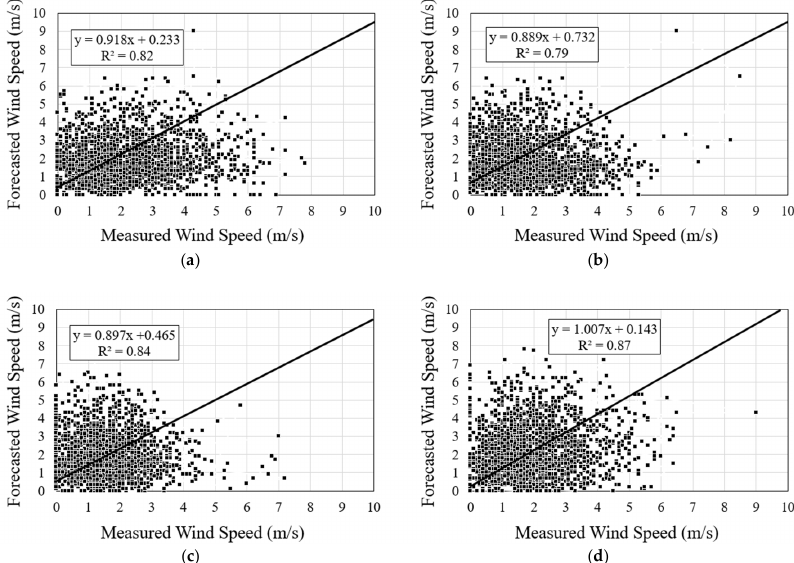
Figure 5. Season-wise comparison of the predicted and measured wind speed at the test site for the year 2015: ( a ) Winter; ( b ) Spring; ( c ) Summer; ( d ) Autumn.